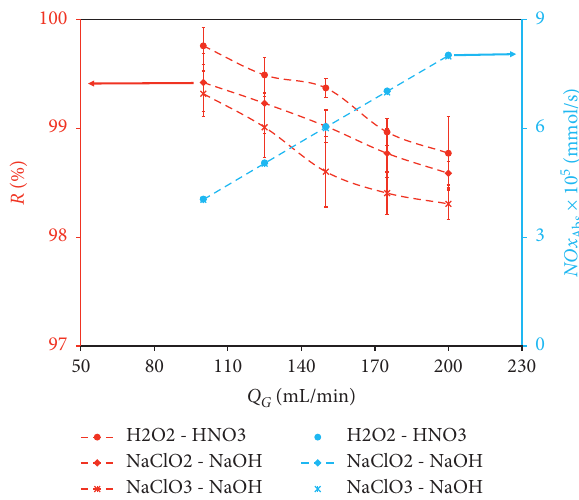
Figure 4: The feed gas flow rate, Q G , effects on the NOx removal efficiency, R , and the amount of NOx absorbed NOxAbs in a 40 fiber membrane module using 400 mL of absorbent pairs of H 2 O 2 (0.05 M) - HNO 3 (0.25 M), NaClO 2 (0.05 M) – NaOH (0.25 M), and NaClO 3 (0.05 M) – NaOH (0.25